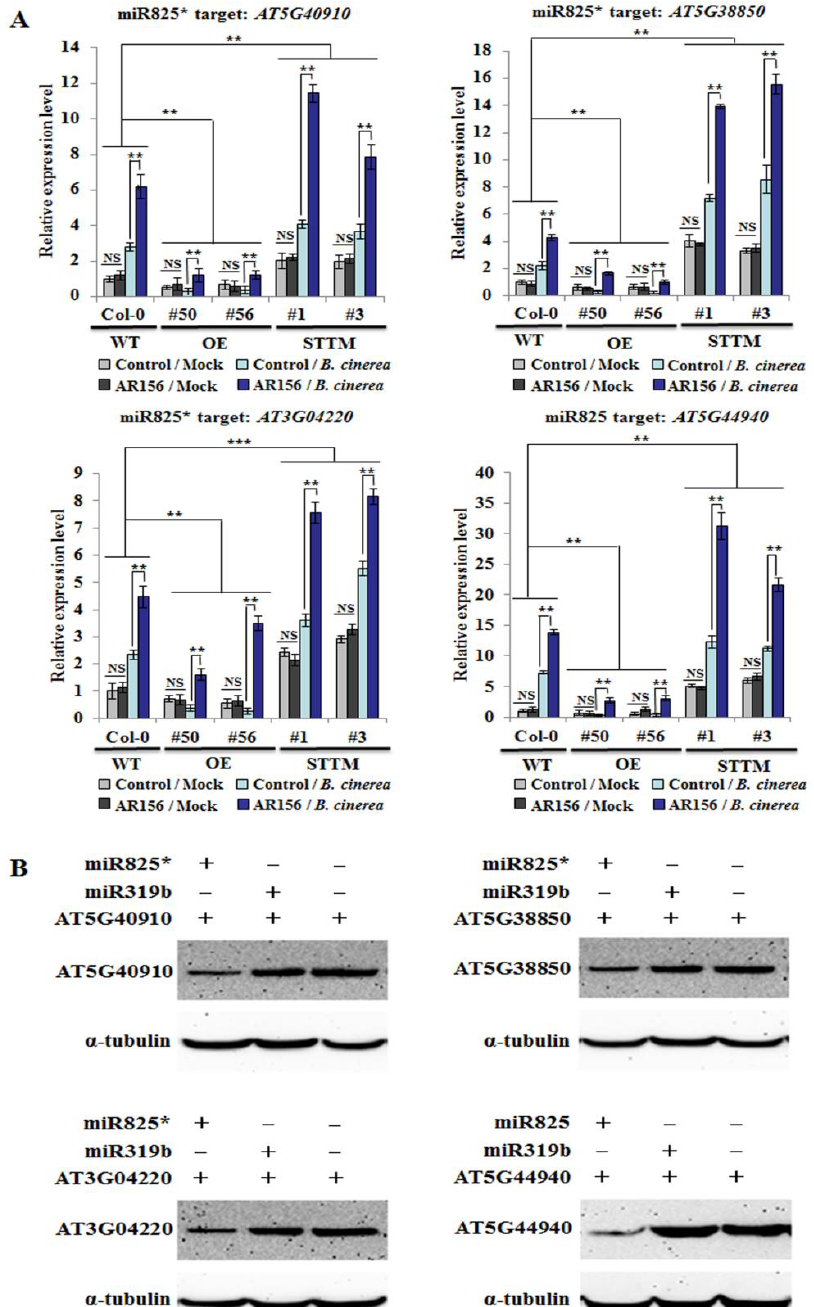
Figure 5. Theexpression level of target genes of miR825 and miR825* in di ff erent genotypes. ( A ) Expression profiles of AT5G40910 , AT5G38850, AT3G04220 (miR825* targets), and AT5G44940 (a miR825 target) in Col-0, miR825 / 825* OE lines (#50 and #56), and STTM825 / 825* transgenic lines (#1 and #3) during AR156-triggered ISR. Three-week-old plants were pretreated with AR156 at 5 × 10 8 CFU / mL or 0.85% NaCl (the control) as a root drench; at 7 dpt, leaves were challenge-inoculated as depicted above. At 48 hpi, total RNA was extracted from leaves. The data are presented as mean ± SD from three biological replicates. Two-way ANOVA indicated significant e ff ects of genotype on the expression of AT5G40910 , AT5G38850 , and AT5G44940 ( P < 0.01 for the di ff erences between WT and OE, and also for those between WT and STTM) and on AT3G04220 expression ( P < 0.01 and P < 0.001 for the di ff erences between WT and OE, and between WT and STTM, respectively); and a significant treatment e ff ect ( P < 0.01) and a significant interactive e ff ect ( P < 0.01) on the expression of each tested gene. Note: NS, not significant; ** P < 0.01; *** P < 0.001. ( B ) Co-expression of miR825/miR825* and the